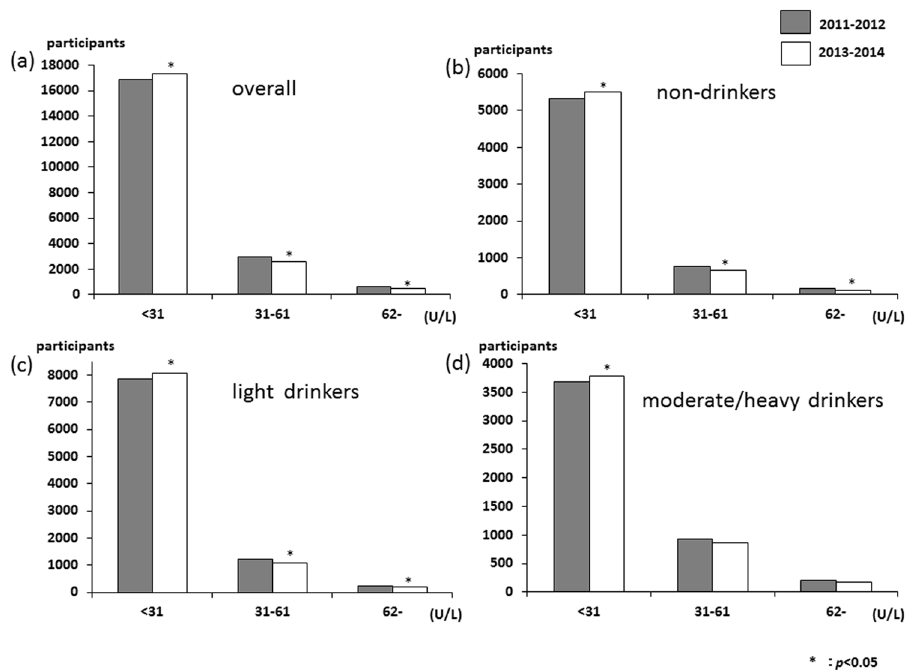
Figure 2. Distribution of serum ALT ( a ) over all (n = 20395), ( b ) non-drinkers (n = 6264), ( c ) light drinkers (n = 9315), and ( d ) moderate/severe drinkers (n =